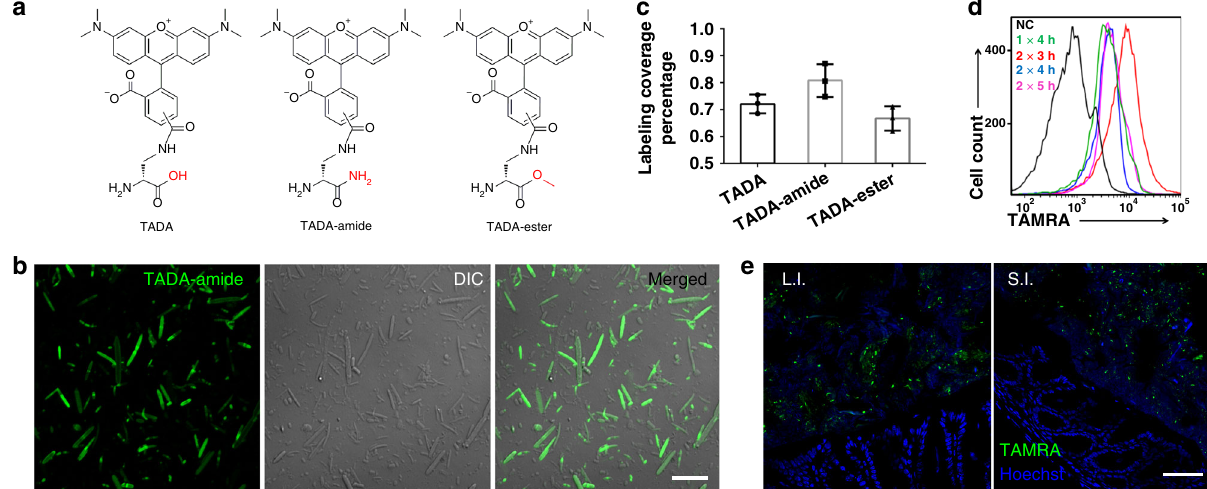
Fig. 2 The FDAA probes used in this study and their labeling of gut microbiota in vivo. a Structures of TADA, TADA-amide, and TADA-ester. b Confocal fl uorescence images of gut microbes from mice administered with TADA-amide. DIC, differential interference contrast. Scale bar, 10 μ m. c Statistical analysis of the labeling coverage for gut microbes labeled with TADA, TADA-amide, and TADA-ester. Mean± s.d. are presented for n = 3. d Flow cytometry analysis of TADA-amide-labeled gut microbiota with different labeling time. NC negative control; 1 × 4 h, one gavage and microbiotas collected 4 h later; 2 × 3 h, two gavages with a 3 h interval, and microbiotas collected 3 h after the second gavage. e Confocal fl uorescence imaging of the transplanted gut microbiota (green) on the tissue sections of the recipient mouse ’ s large intestine (L.I.) and small intestine (S.I.). Hoechst 33342 (blue) was used for nuclear counterstain. In b , e , representative results from three independent experiments are shown. Scale bar, 50 μ